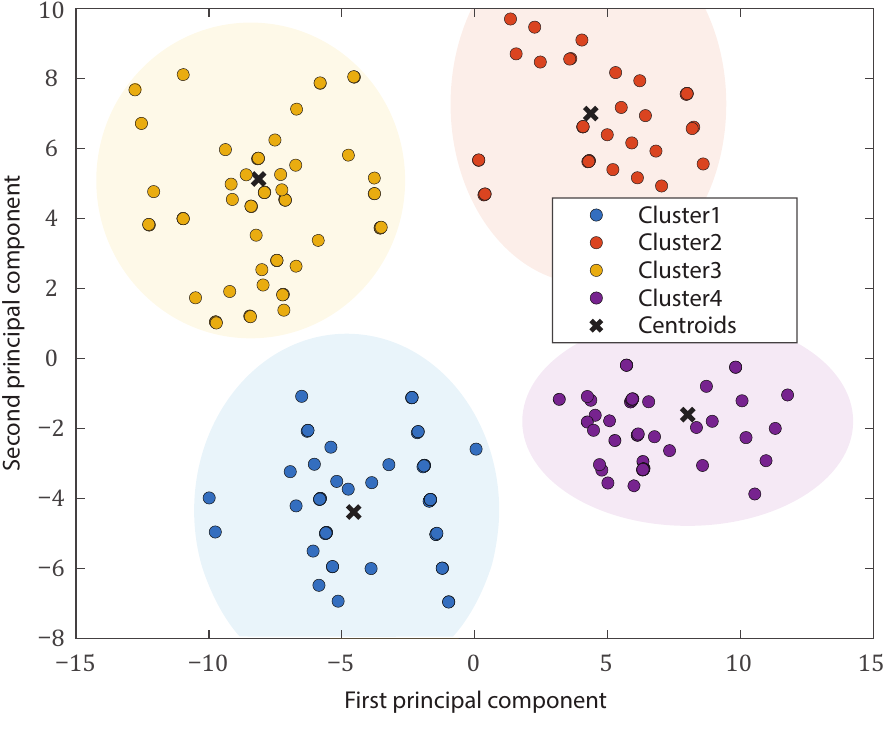
Figure 13. Clusters and Centroids.